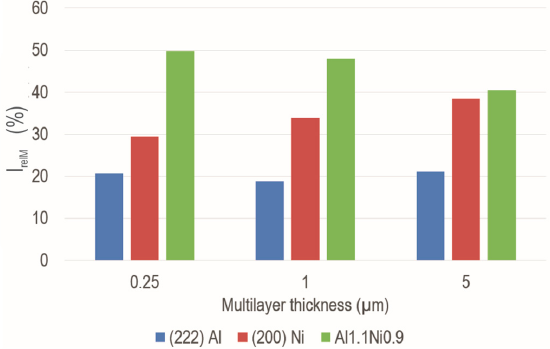
Figure 6. Relation between the intensities of selected peaks as marker for Al, Ni, and Al 1.1 Ni 0.9 content after RTA treatment at 350 °C.